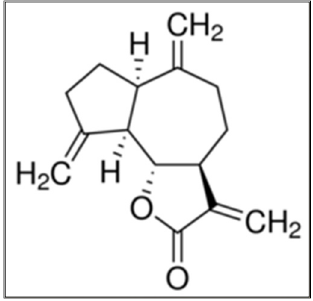
Figure 5. Formula for the structure of a dehydrocostus lactone.